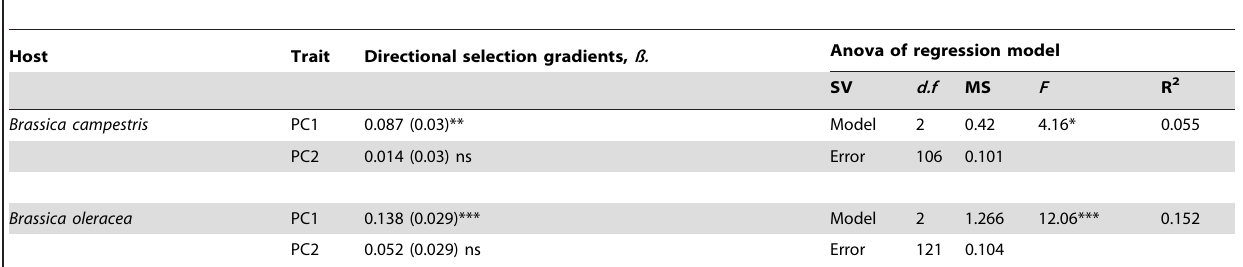
Table 4. Lineal regression analysis of relative fitness as a function of morphological traits (PC1 and PC2) of Brevicoryne brassicae from two host plants.